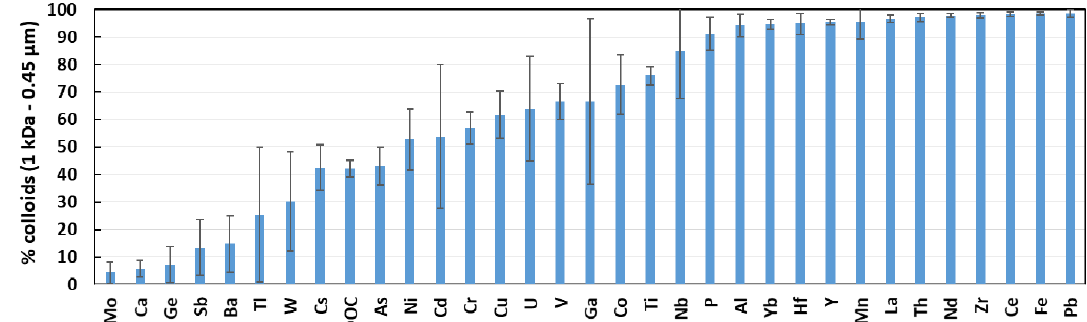
Figure 5. Proportion of the colloidal fraction of elements in the Ob River downstream of the Irtysh (4 points) and 3 tributaries (Pasaydeyakha, Poluy and Pitljar). Alkalis and alkaline-earth metals and oxyanions exhibited <10% of colloids and are not shown here.